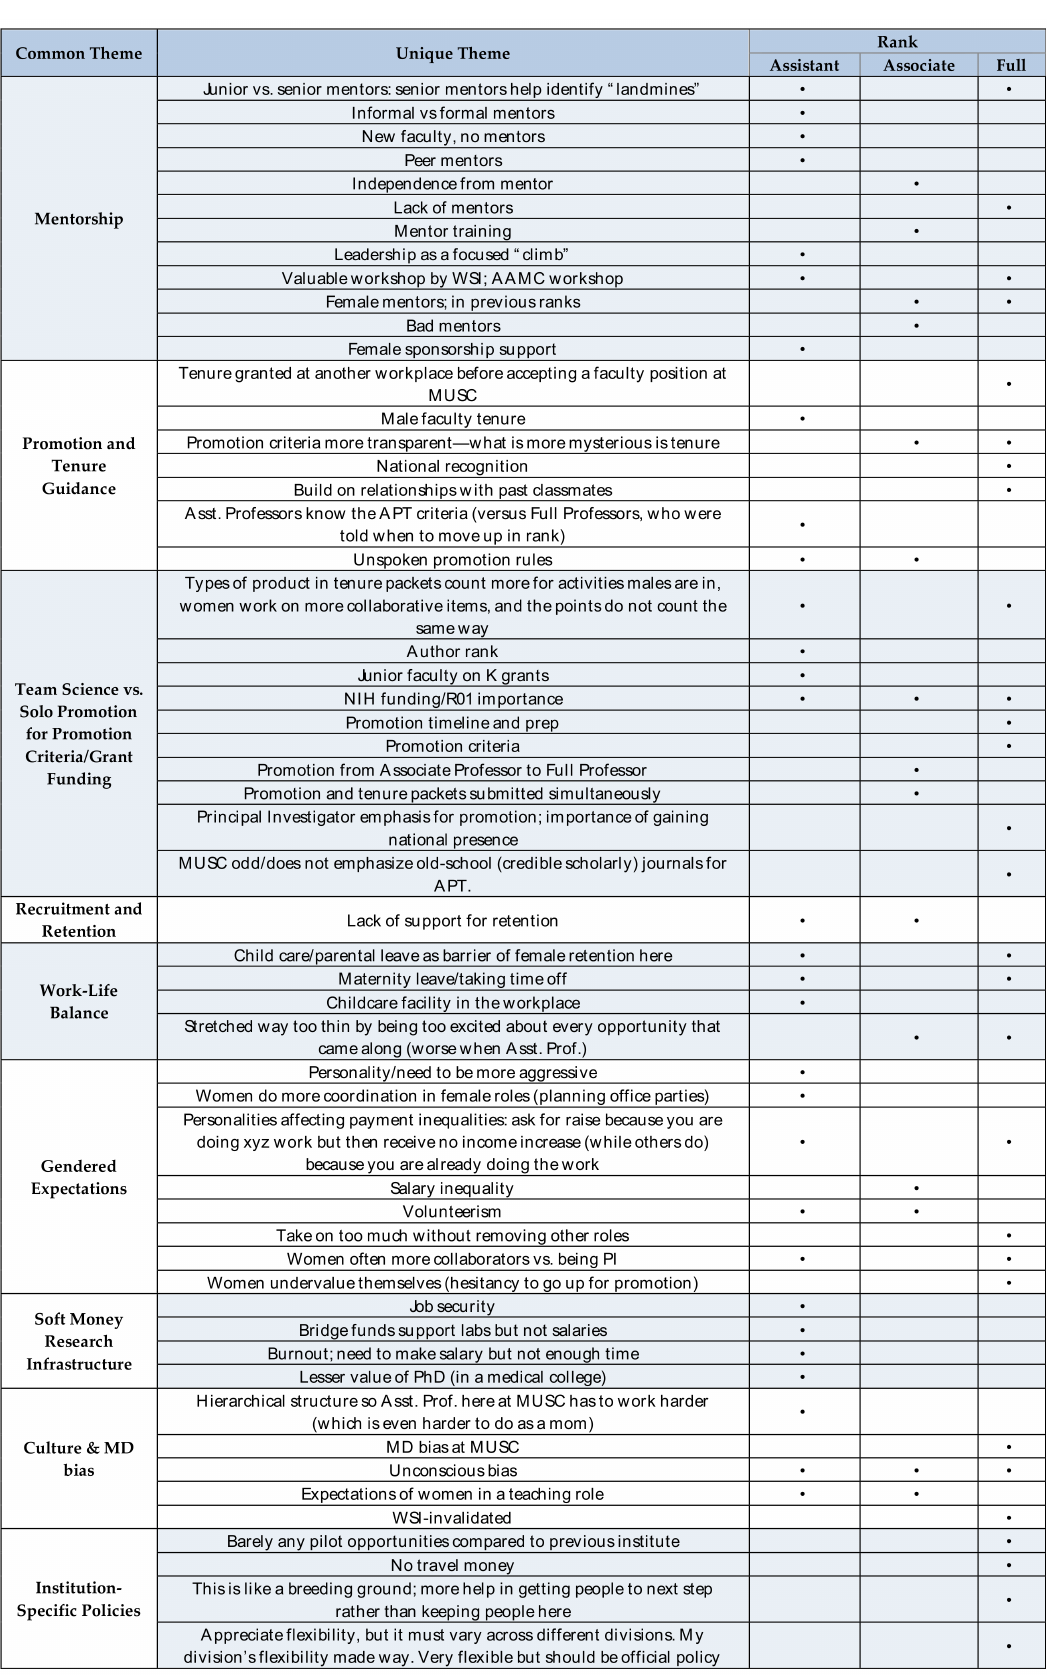
Figure 2. Emerging Themes and Subthemes Across all Focus Group Sessions ( n =